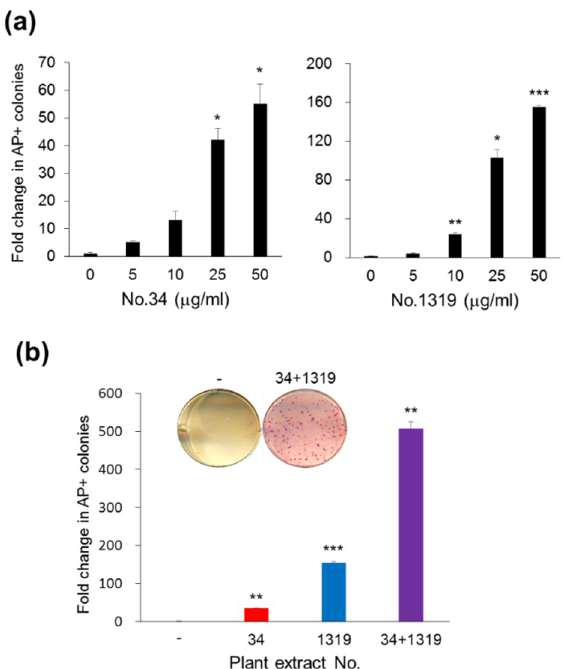
Figure 3. Synergistic effects of fruit and stem extracts of CJ on hiPSC generation. ( a ) Dose-dependent enhancement of reprogramming efficiency by CJ extracts (No. 34: stem and No. 1319: fruit). OSKM-transduced hFFs were incubated with or without CJ extracts at the indicated concentrations. ( b ) CJ stem and fruit extracts exhibited synergistic effects on stimulated reprogramming with each other. hFFs were transduced by OSKM-SeV and cultured with No. 34, No. 1319 (50 µ g/mL), and the combination of No. 34 and No. 1319 (in half at a final concentration of 50 µ g/mL). The human ESC (hESC)-like colonies were stained for AP and quantified to determine reprogramming efficiency. The relative fold changes in AP+ colonies compared with untreated controls (designated as 1) are presented. The results are presented as the mean + SEM ( n = 3). Statistical significance was determined using Student’s t -test (* p < 0.05, ** p < 0.01, *** p < 0.001).